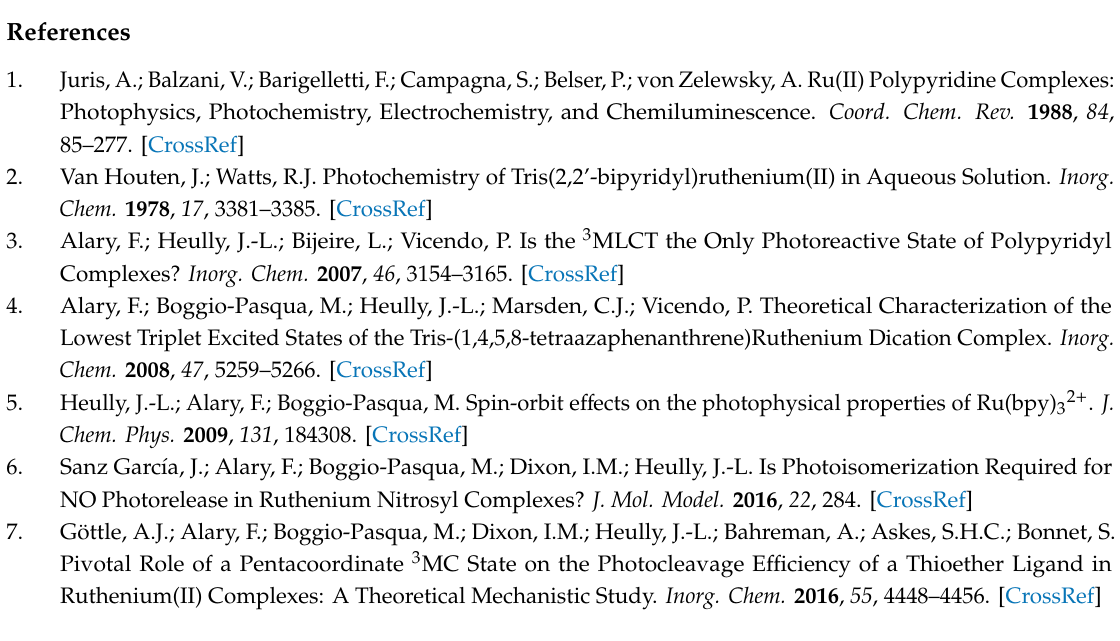
Figure S1: MO diagram schematizing the interaction between the metallic fragment in the 3 MC state and the approaching acetonitrile ligand; Figure S2: MO diagram at selected points along the reaction path; Cartesian coordinates of the 20 beads along the minimum energy